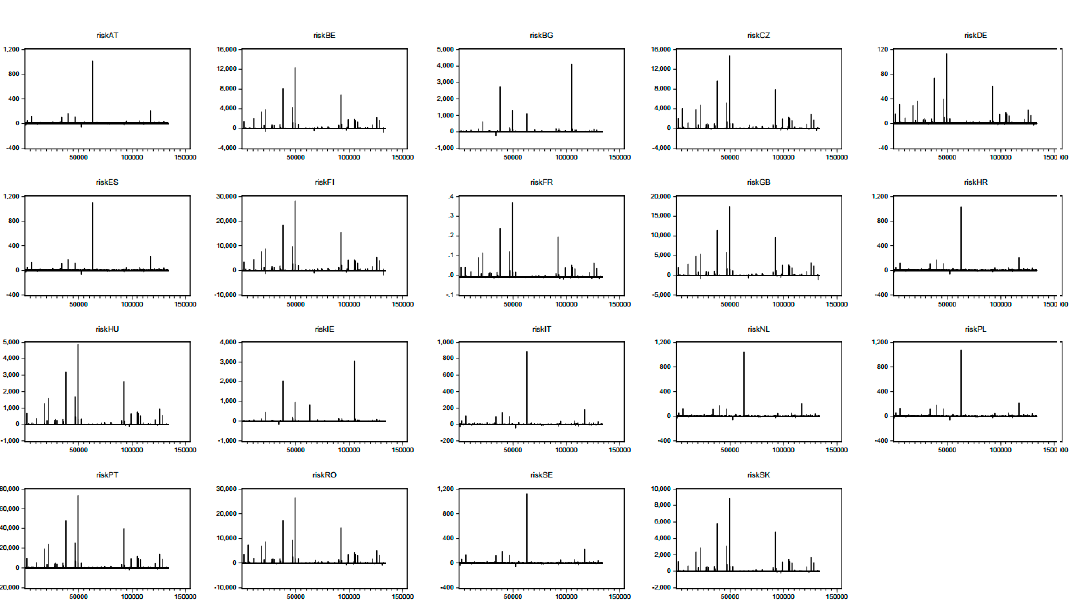
Figure 2. Plot of scoring bankruptcy risk by country. Source. Performed by the authors based on data provided by Amadeus database. Table 4. Number of firms after limiting the risk values by country and